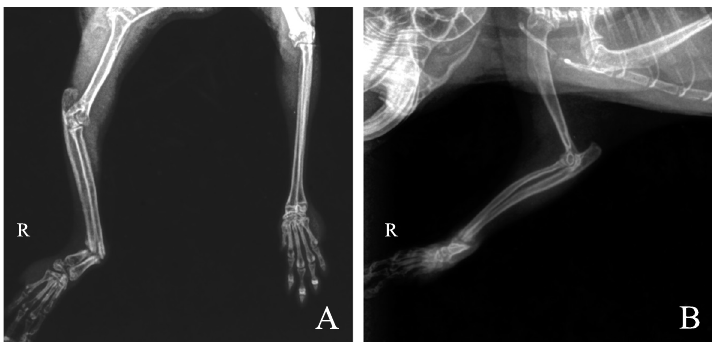
Fig. 1 X-ray results of the affected forlimb. A Dorsoventral view; B Right lateral view. A and B showed oblique fractures of the radius and distal ulna with a distinct